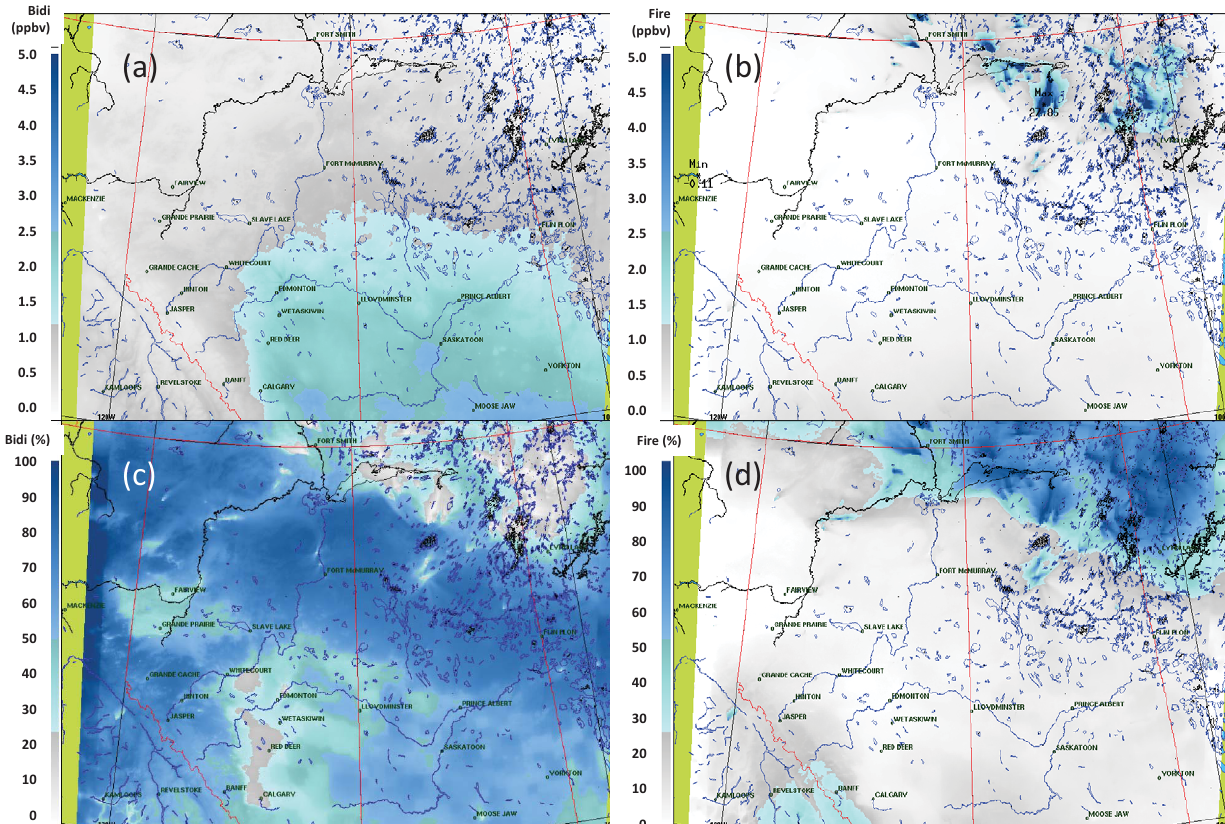
Figure 12. Maps of the modelled (a) absolute bidirectional flux contribution, (b) absolute fire contribution, (c) percent bidirectional flux contribution, and (d) percent fire contribution to surface NH 3 . These are averages over 12 August to 7 September 2013.